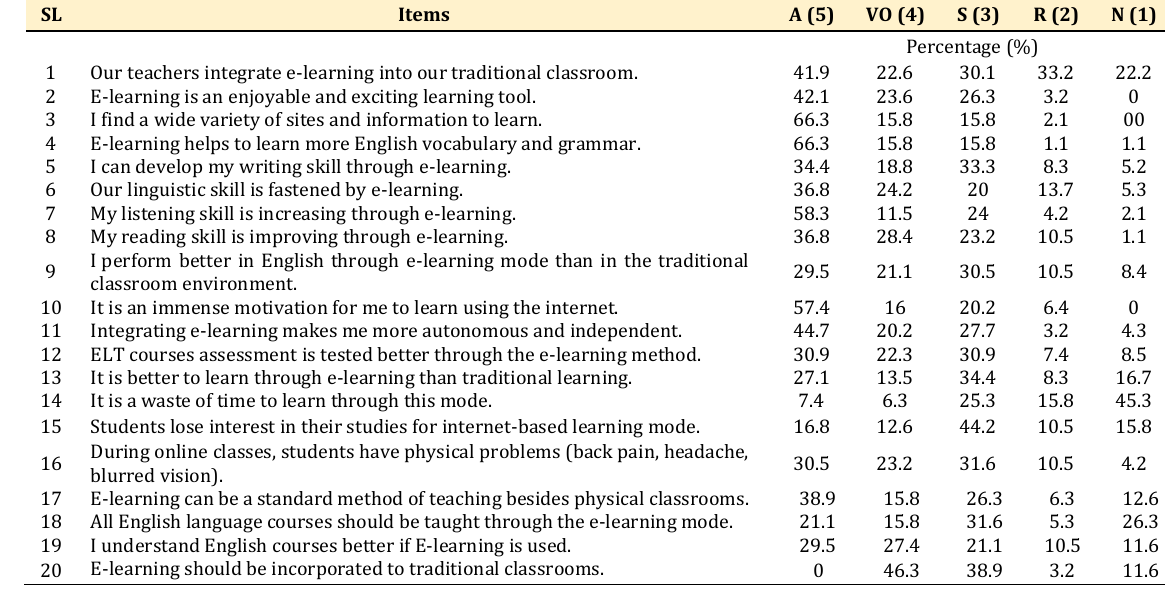
Table 1. Participants' Responses to the sustainability of e-learning in the EFL